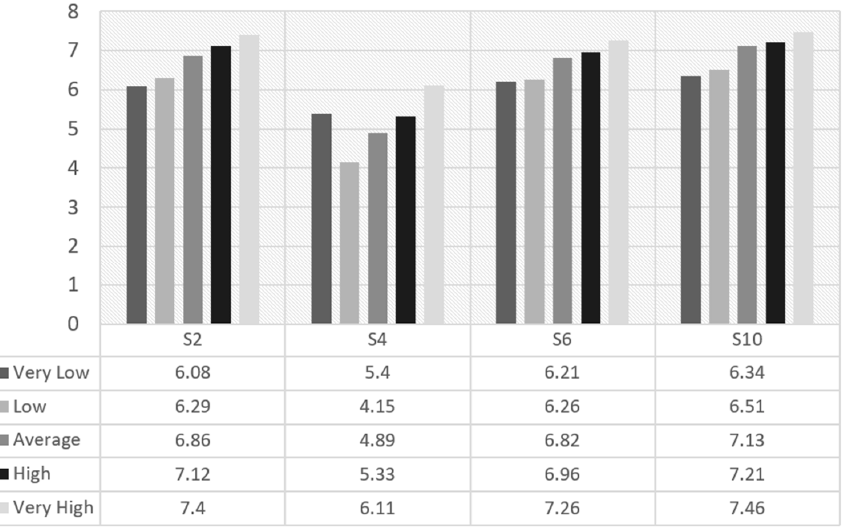
Figure 2. S2 (Revitalization and Enjoyment), S4 (Competition), S6 (Strength and Endurance) and S10 (Challenge) scoring by Cardiorespiratory Fitness in girls.